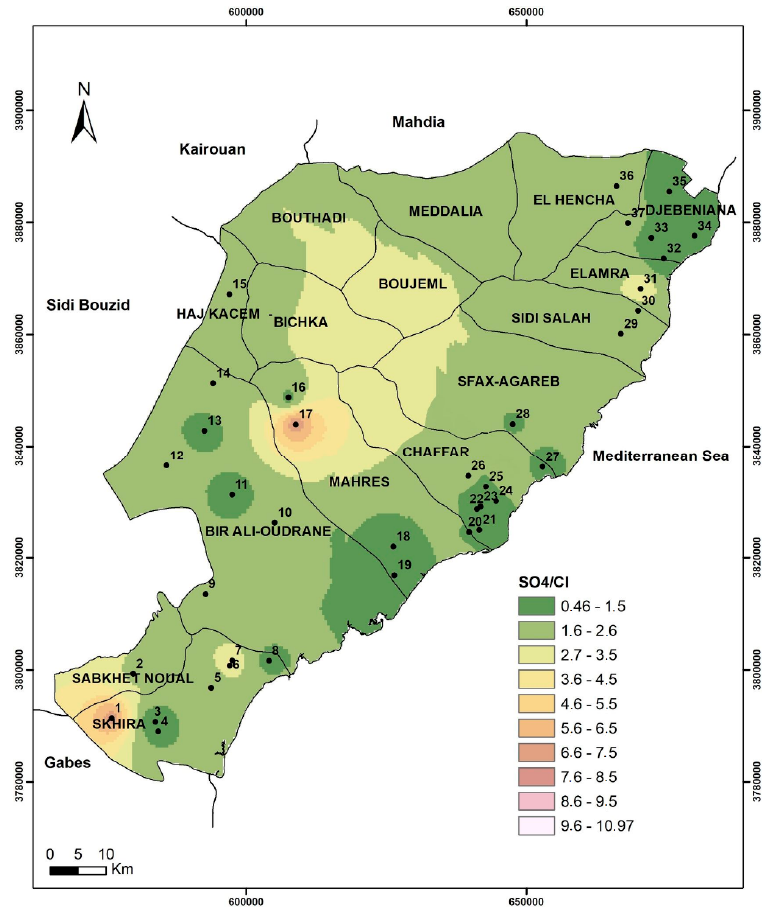
Figure 10. SO 4 /Cl geospatial distribution in the study area.